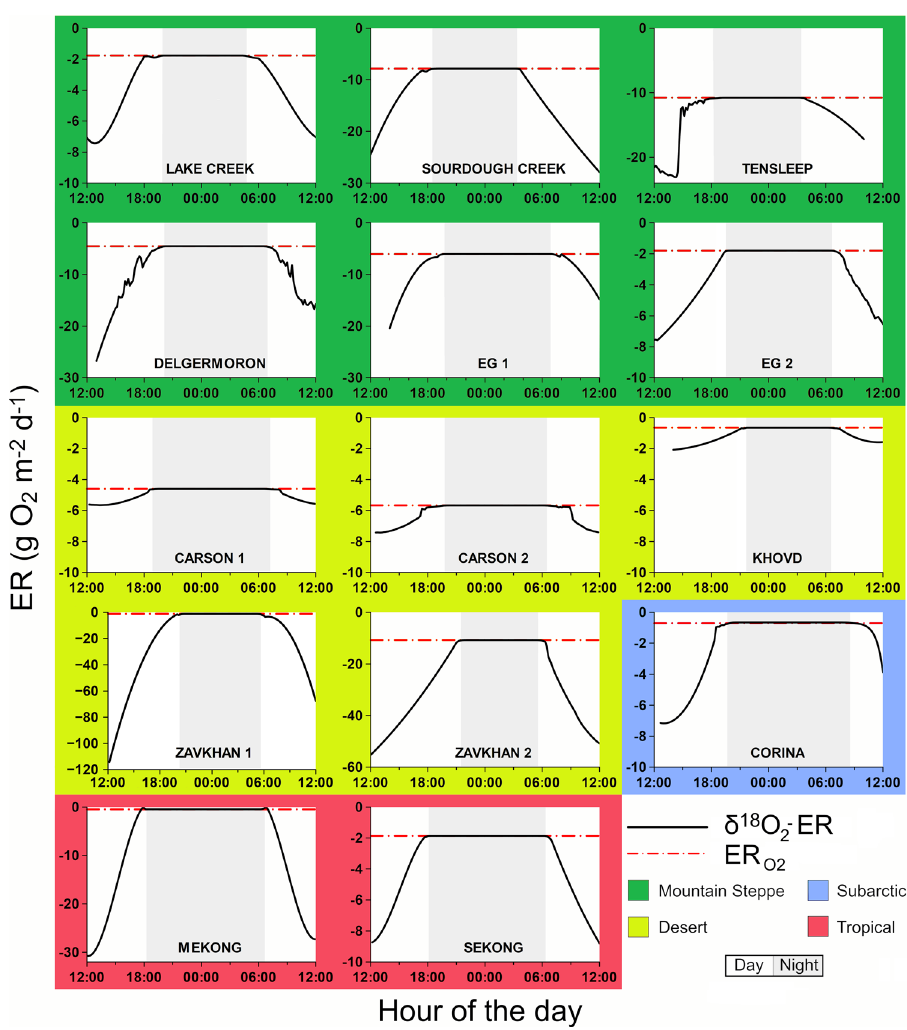
Fig. 2 Diel rates of ecosystem respiration δ 18 O 2 -ER from dual δ 18 O 2 and O 2 model compared to ER O2 from O 2 -only model. Ecosystem respiration (ER) in rivers estimated as diel δ 18 O 2 -ER (solid lines from dual δ 18 O 2 and O 2 model) compared to ER O2 (dashed red line from the O 2 -only model). Green panels represent mountain steppe sites, yellow panels desert sites, and red panels tropical sites. The gray shading represents night